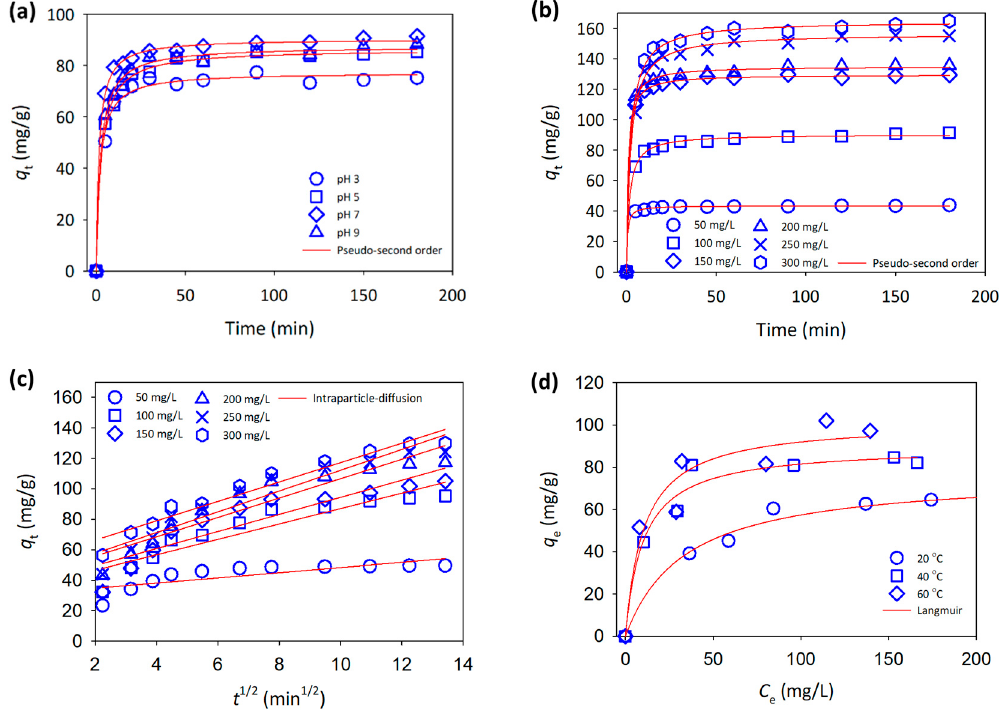
Figure 3. Adsorption models of MB onto 3D printed CNF for ( a ) different initial pH, ( b ) pseudo- second order, ( c ) intraparticle diffusion, and ( d ) Langmuir isotherm.